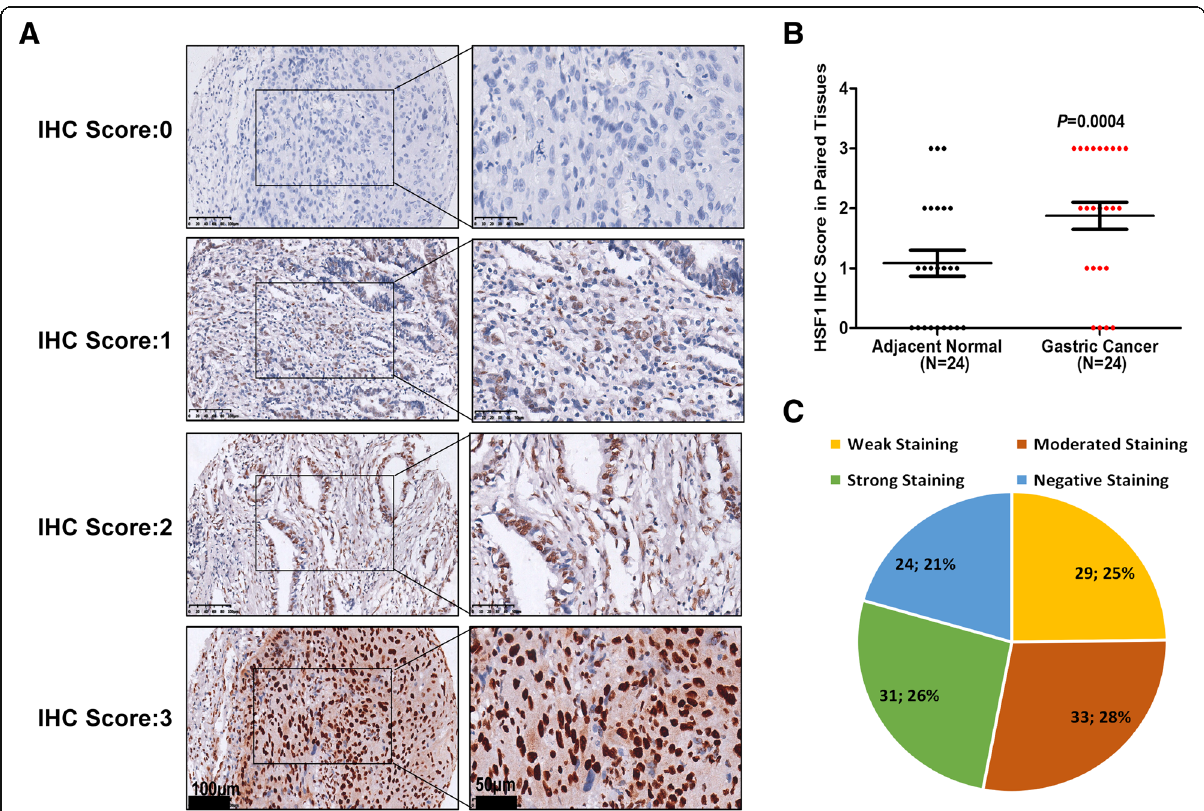
Fig. 2 HSF1 protein expression in normal tissues and GC tissues. ( a ) IHC staining of HSF1 protein in GC tissues. IHC score was determined according to the percentage of positively staining cells (IHC score: 0, negative staining; IHC score: 1, < 20% of positively staining cells; IHC score: 2, 20 – 50% of positively staining cells; IHC score: 3, > 50% of positively staining cells); ( b ) HSF1 protein expression was significantly increased in primary tumour specimens compared with adjacent non-tumour tissues by IHC ( P =0.0004, N =24); ( c ) Percentage of patients with GC according